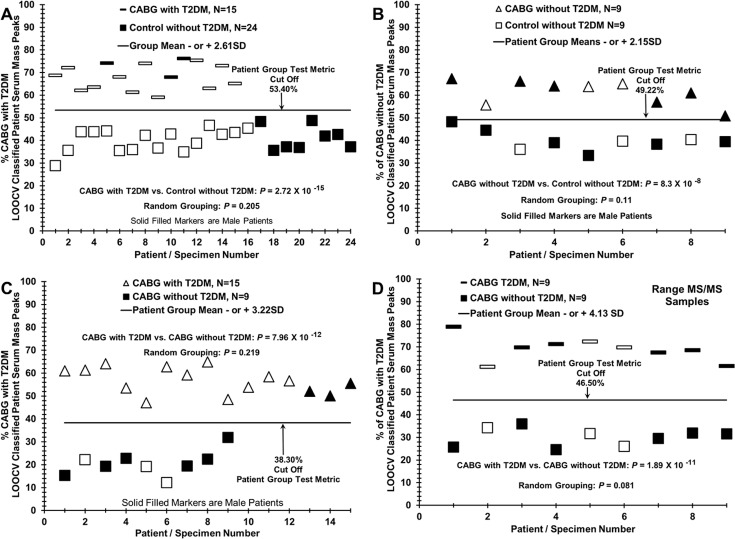
Distinguishing sera of CABG T2DM patients versus controls and CABG patients without T2DM.(A) Sera discrimination of patients with CABG with T2DM (dashes) versus sera from control individuals (squares) by % of LOOCV classified mass peak analysis. (B) Sera discrimination of patients with CABG without T2DM (triangles) versus sera from control individuals (squares). (C) Sera discrimination of CABG patients with T2DM (triangles) from CABG patients without T2DM (squares). (D) Discrimination of the sera samples in the 9 versus 9 grouping of patients with CABG plus T2DM (dashes) versus CABG without T2DM (squares) used in tandem MS/MS peptide/protein analysis exhibited in Table 3 and S1 Table.